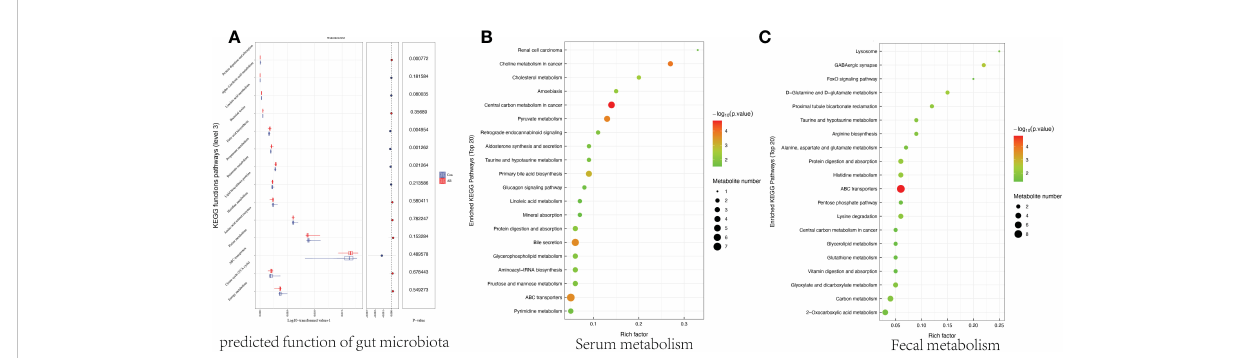
FIGURE 8 Correlation among key differential gut microbiota (genus level), differential fecal metabolites, and differential serum metabolites. (A) Correlation between key differential gut microbiota (genus level) and differential fecal metabolites. (B) Correlation between key differential gut microbiota (genus